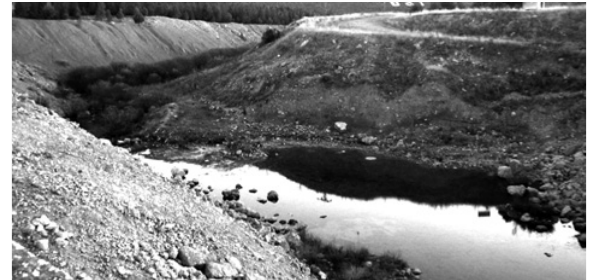
Fig. 14. View of new trapezoidal cross-section in Goksu downstream (November